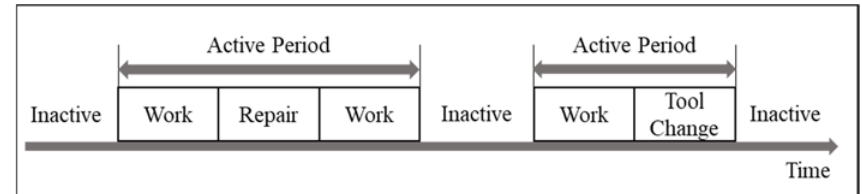
Figure 8. The active period of a machine during production.